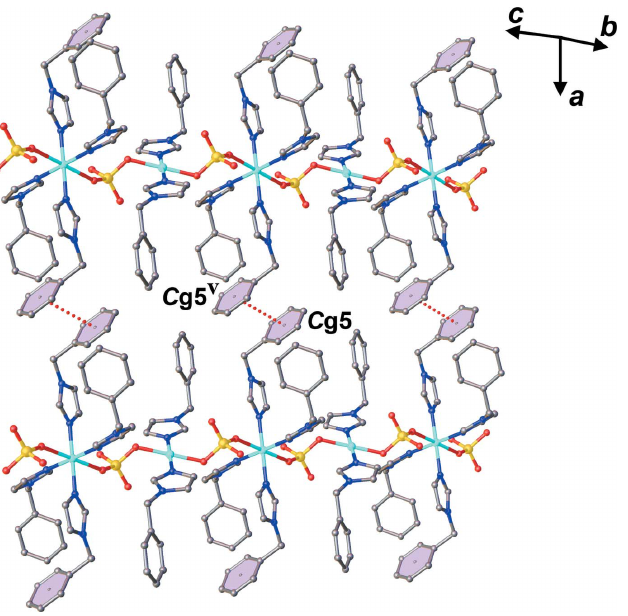
O—H (cid:2) (cid:2) (cid:2) O hydrogen-bonding interactions between the brid- ging sulfate ion in the chain and the solvate water and DMF molecules are found (Table 1; Fig. S3 in the supporting information). Intermolecular interactions between adjacent chains (Fig. 3 a ) exist through hydrogen-bonding interactions between a methylene group and a sulfate ligand, C4— H4 (cid:2) (cid:2) (cid:2) O3 ii and C24—H24 B (cid:2) (cid:2) (cid:2) O4 ii (Table 1; Fig. 3 b ) and by C—H (cid:2) (cid:2) (cid:2) (cid:3)